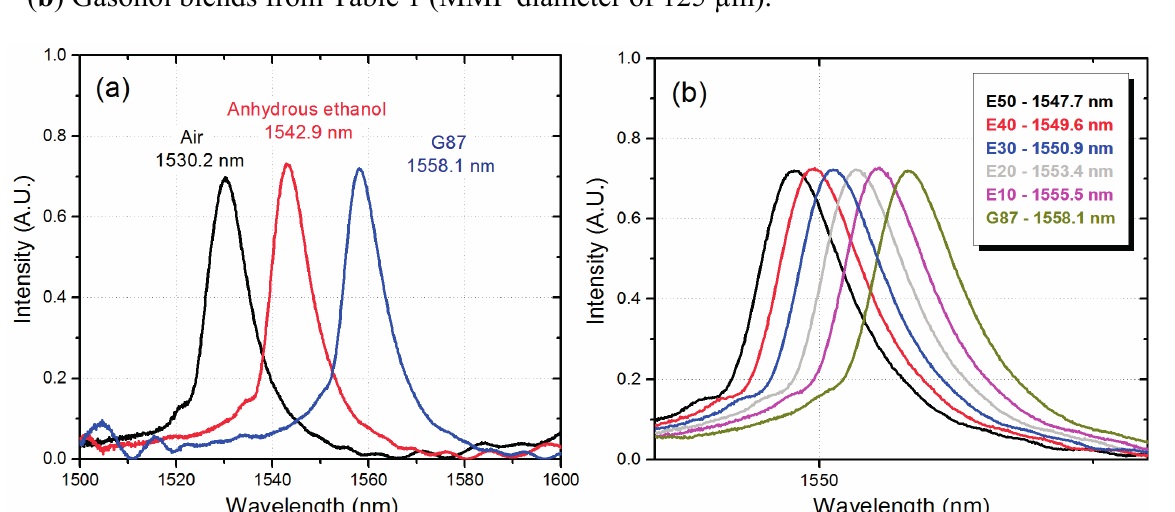
Figure 4. ( a ) Spectral response of the MMI sensor for anhydrous ethanol and G87 gasoline; ( b ) Gasohol blends from Table 1 (MMF diameter of 125